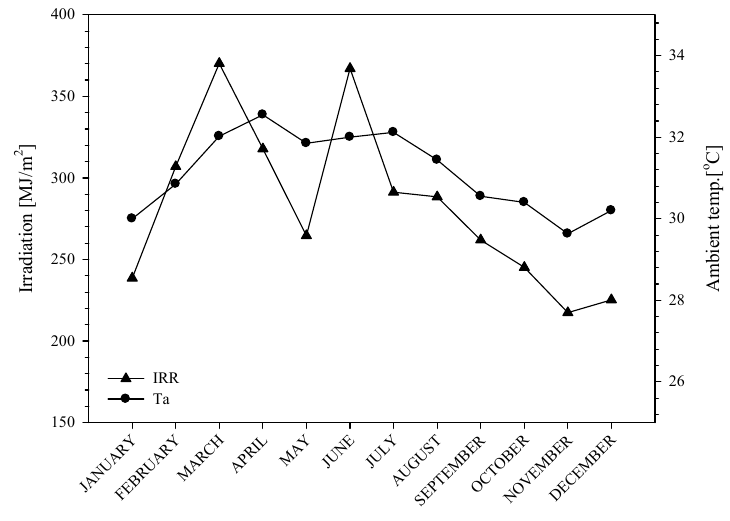
Figure 5. Solar radiation and ambient temperature in Bangkok.